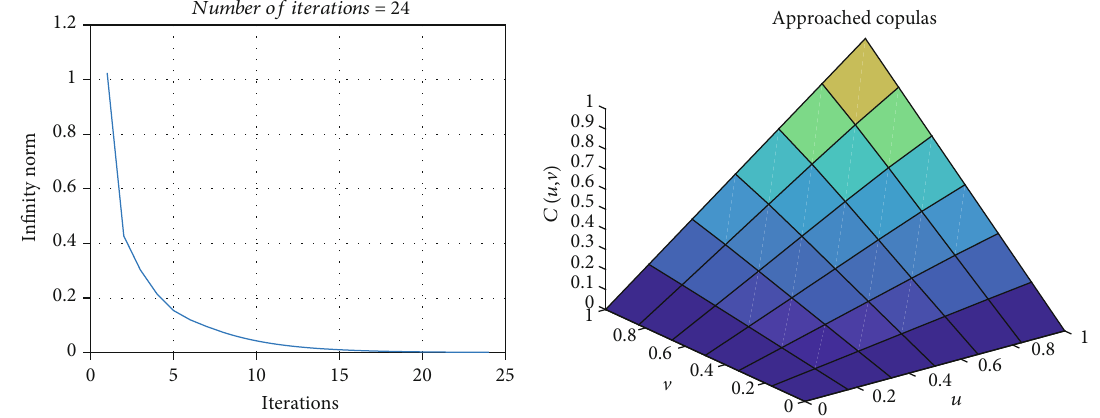
Figure 4: Approached solution of fi nite di ff erence method when N = 5, h = 1/6 , and k = 0